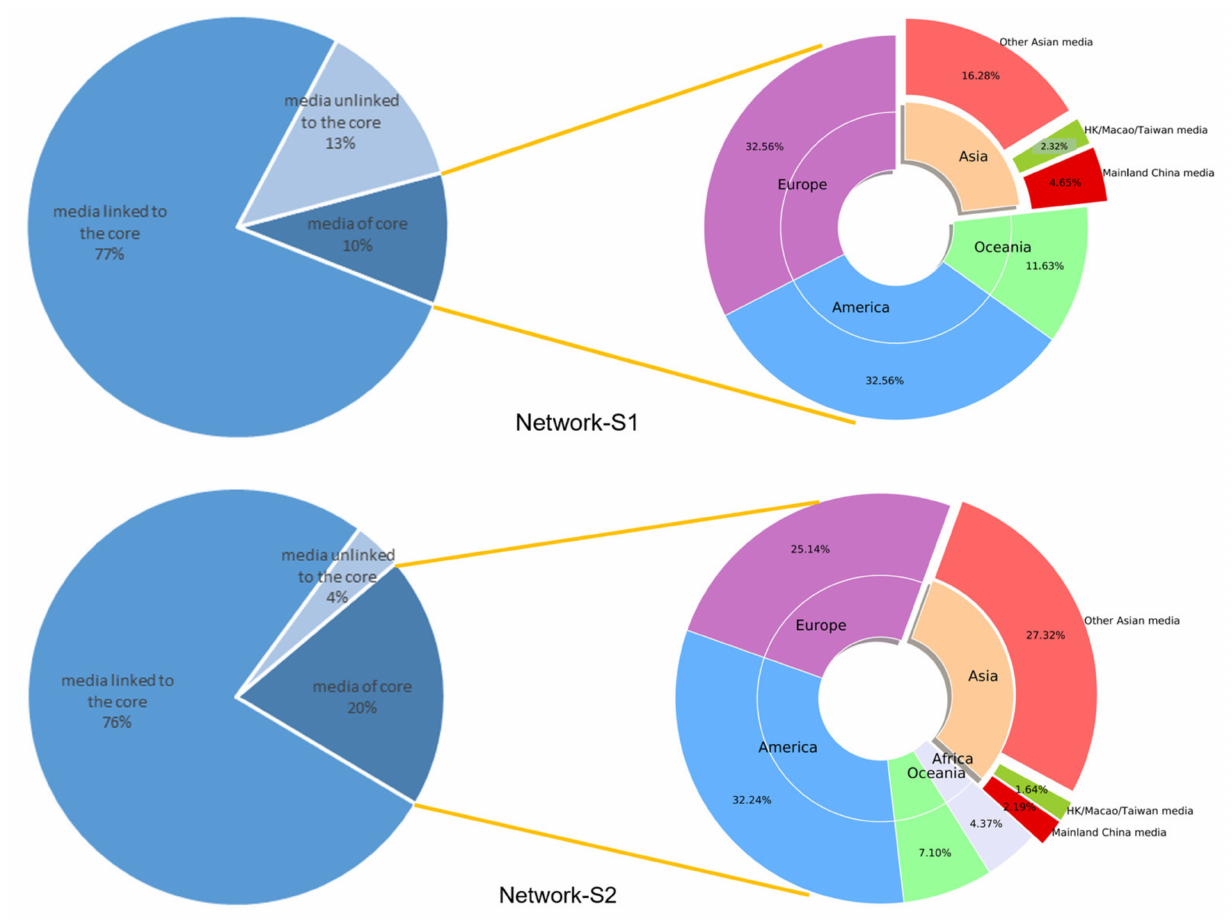
Figure 8. The composition and diffusion range of the